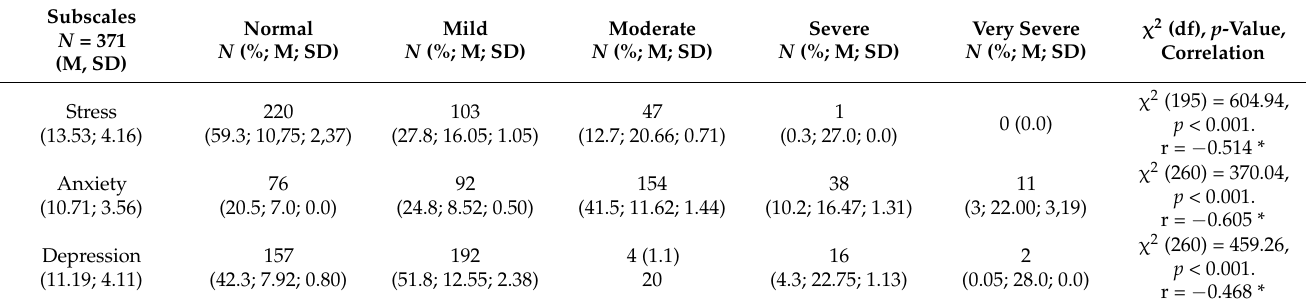
Table 2. Relationship between mindfulness and the severity of stress, anxiety, and